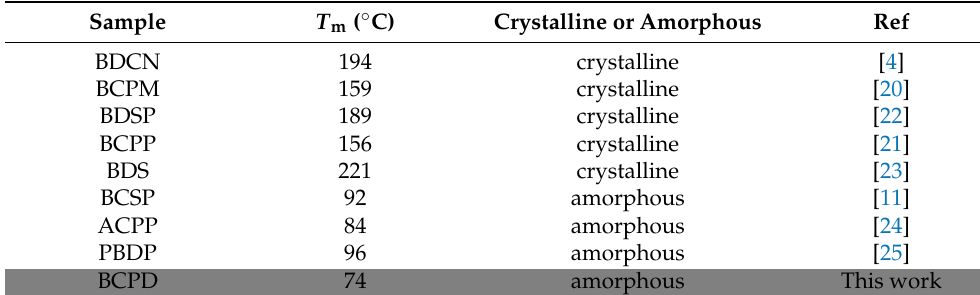
Table 1. The comparison of several phthalonitriles’ T m